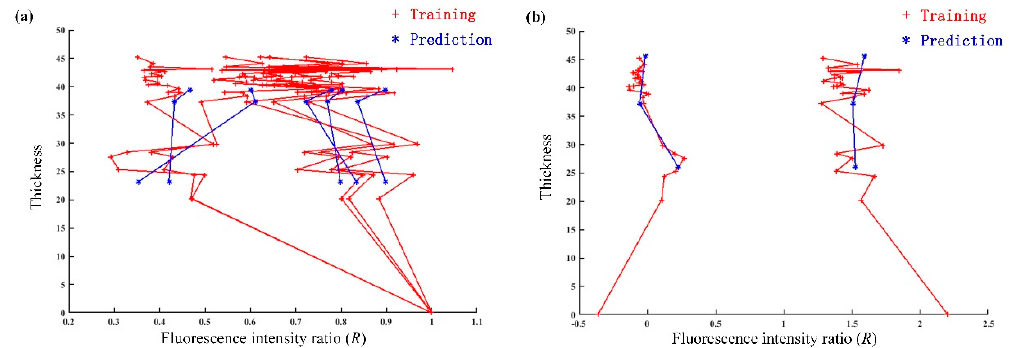
Figure 6. The changing trend of training values and predicted values (( a ) refers to the RBF model; ( b ) refers to the PCA-RBF model).